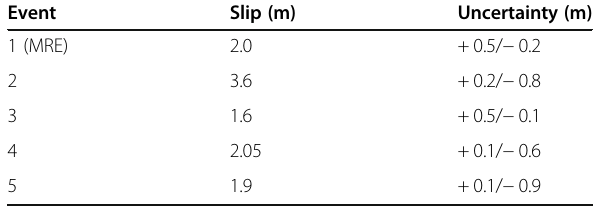
Table 3 Dip slip of the recent 5 events of the VMF Event